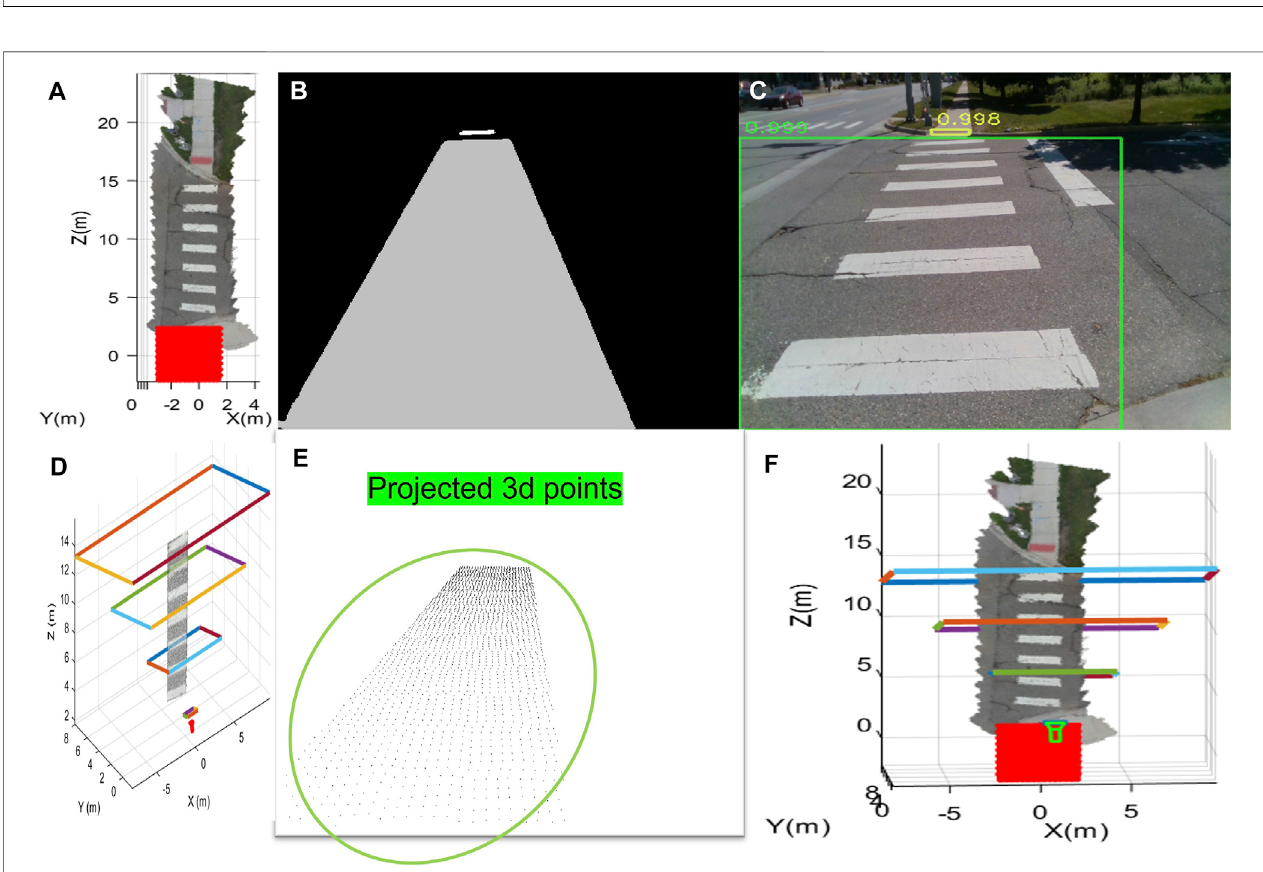
FIGURE5| The fi gure shows the process ofglobal pose estimation. (A) means sampledparticles, (B) is thesegmentation results, and (C) showsthe actual image and howitwassegmented. (D) isanexample ofthefrustumofaparticle (apossibleposefortheuser). (E) isthecorresponding projected imageforthatpose. (F) shows the estimated pose on the prior map as the green camera